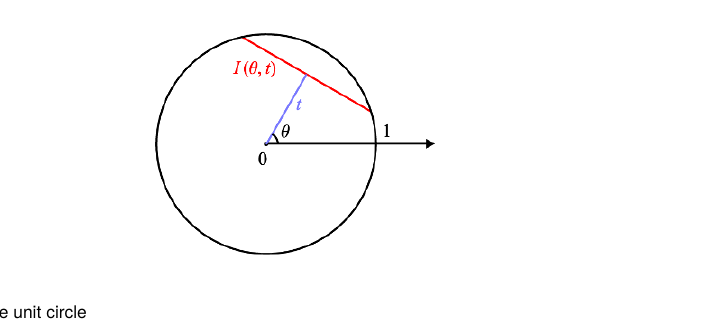
( θ,t ) of the unit circle